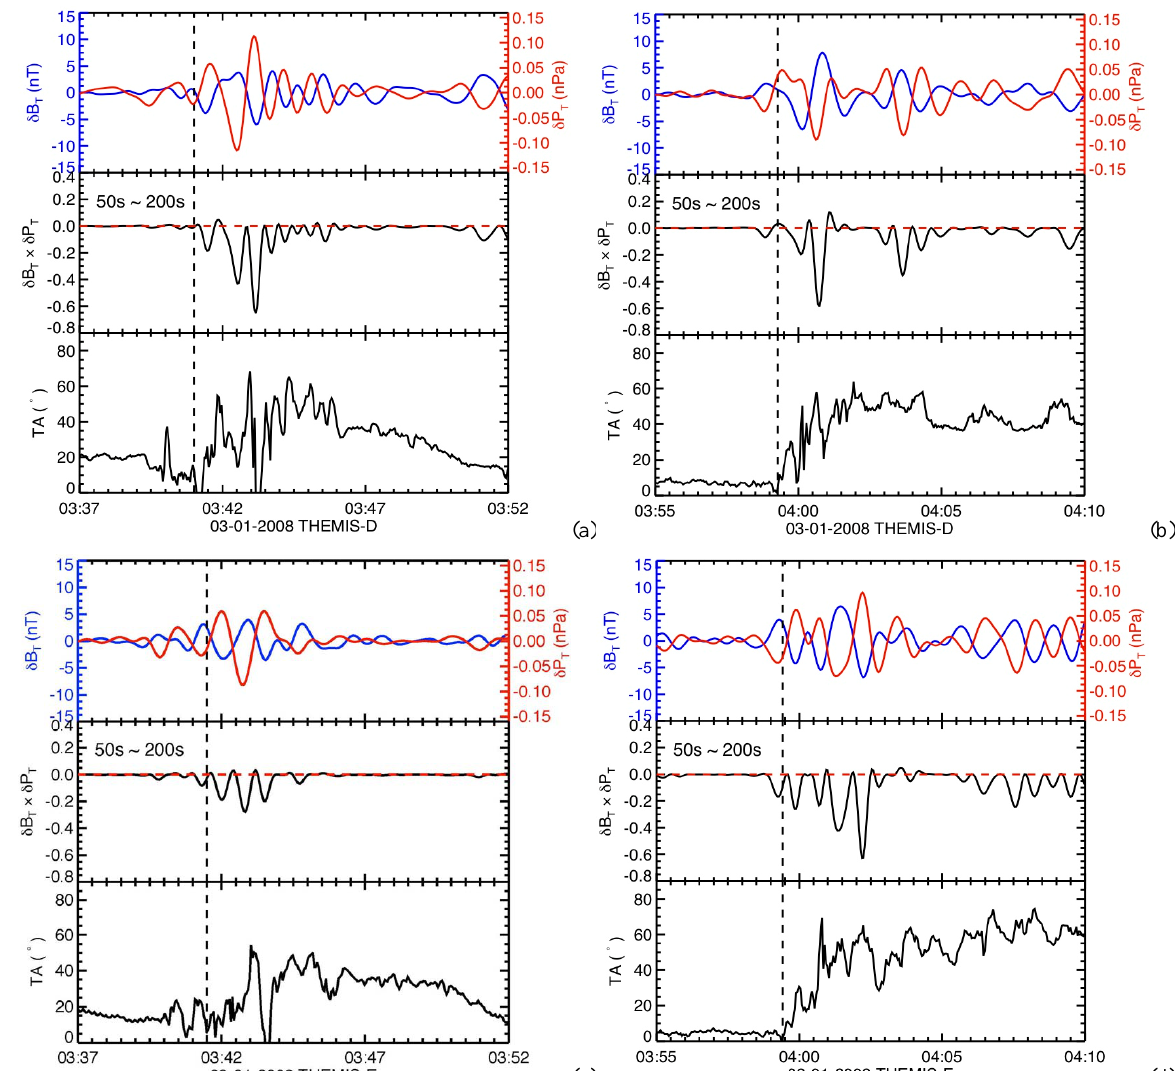
Fig. 5. Figure 5 show that the slow MHD waves dominate the disruption of cross-tail currents in the dipolarization region. (a) and (b) show MHD waves through the band-pass filter [50–200s] on the TH-D data. The high frequency end of the band-pass filter, i.e., 1/50s ∼ 0.02Hz, is chosen to make sure that it is less than ∼ 0.1Hz of the local ion cyclotron frequency shown by the white curve in the wavelet spectrum at the bottom panels of Fig. 1a and b. The top panels of (a) and (b) show the filtered MHD waves in δ B T and δP T . The dashed vertical line in (a) marks the dipolarization onset of the pseudo breakup event in E-1; the dashed line in (b) marks the dipolarization onset of the full-scale substorm breakup event in E-2. The middle panels show the product of δ B T δP T , which is mostly negative, i.e., the waves observed in the dipolarization region are predominantly the slow MHD waves, according to the results of Appendix B. (c) and (d) show the results of filtered TH-E data, displayed in the same format as the TH-D data shown in (a) and (b)